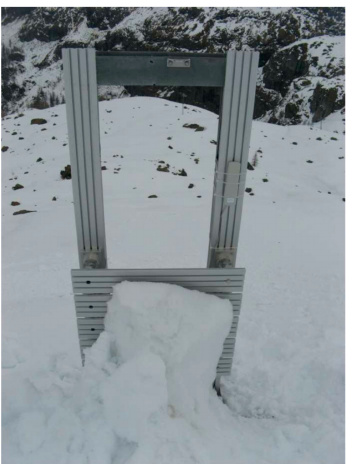
Figure 9. Deposition against the obstacle, due to the spontaneous avalanche on 17 April 2013. Photo E. Bovet on April 24.